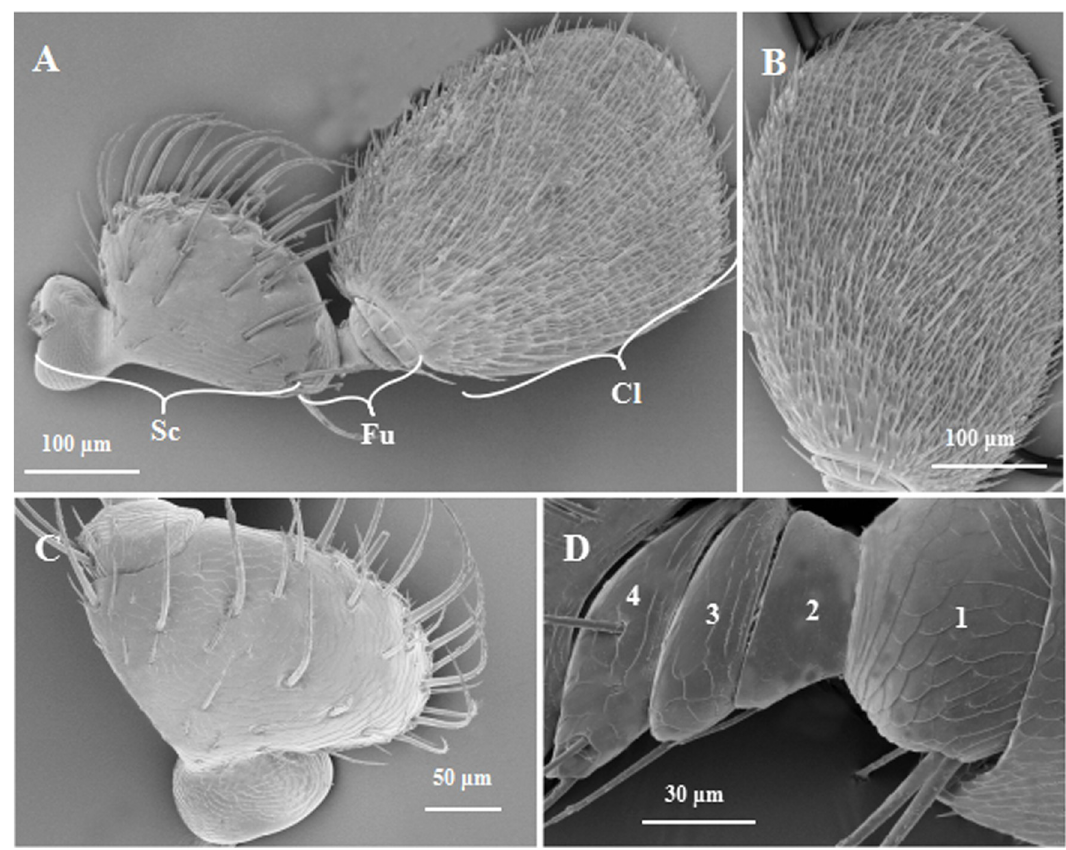
Fig 2. Adult Euplatypus parallelus antennae in frontal vision. A: Geniculated antennae of E . parallelus . B: Club. C: Scape. D: Funicle. Cl: Club; Fu: Funicle; Sc: Scape.